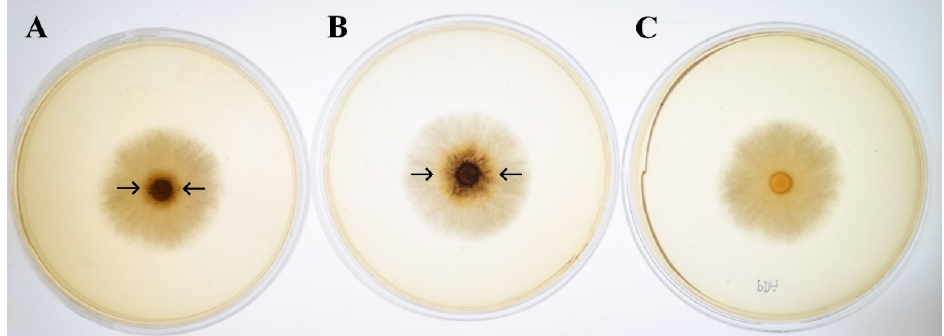
Figure 4. Ligninolytic enzyme activity of T. polyzona KU-RNW027 on agar plates. The fungus was grown on PDA supplemented with 1 mM 2,6-DMP under ( A ) dark and ( B ) continuous lighting conditions. The fungus grown on PDA without 2,6-DMP under light was used as a control ( C ). Ligninolytic enzymes oxidized 2,6-DMP to produce the orange product of the benzoquinone compound. Arrows indicate visualization of the enzyme activity.